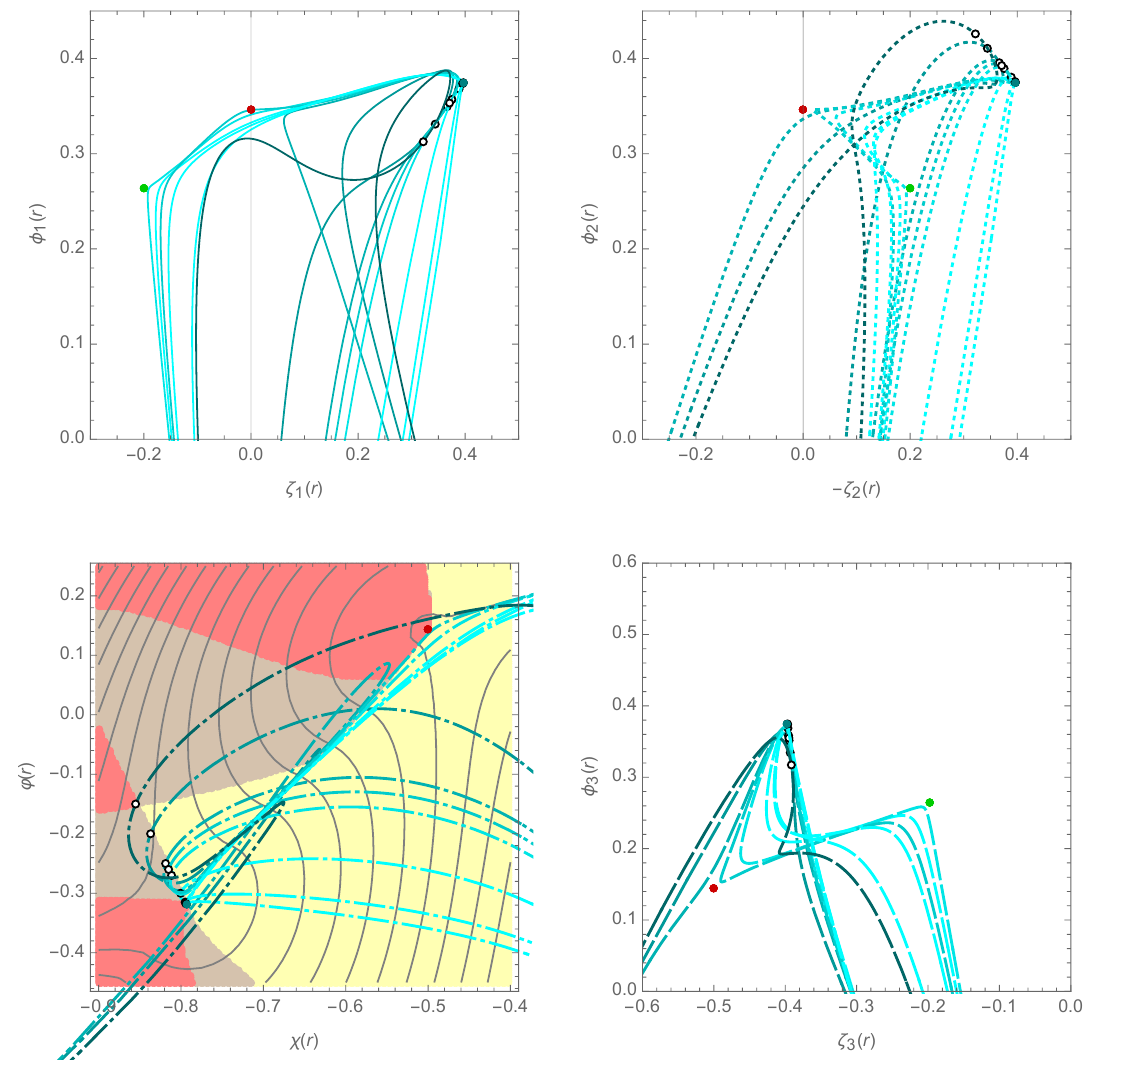
Figure 20. Space of N = 1 Janus solutions with SO(3) symmetry and turning points on the boundary between yellow and grey regions toward the SO(4) critical